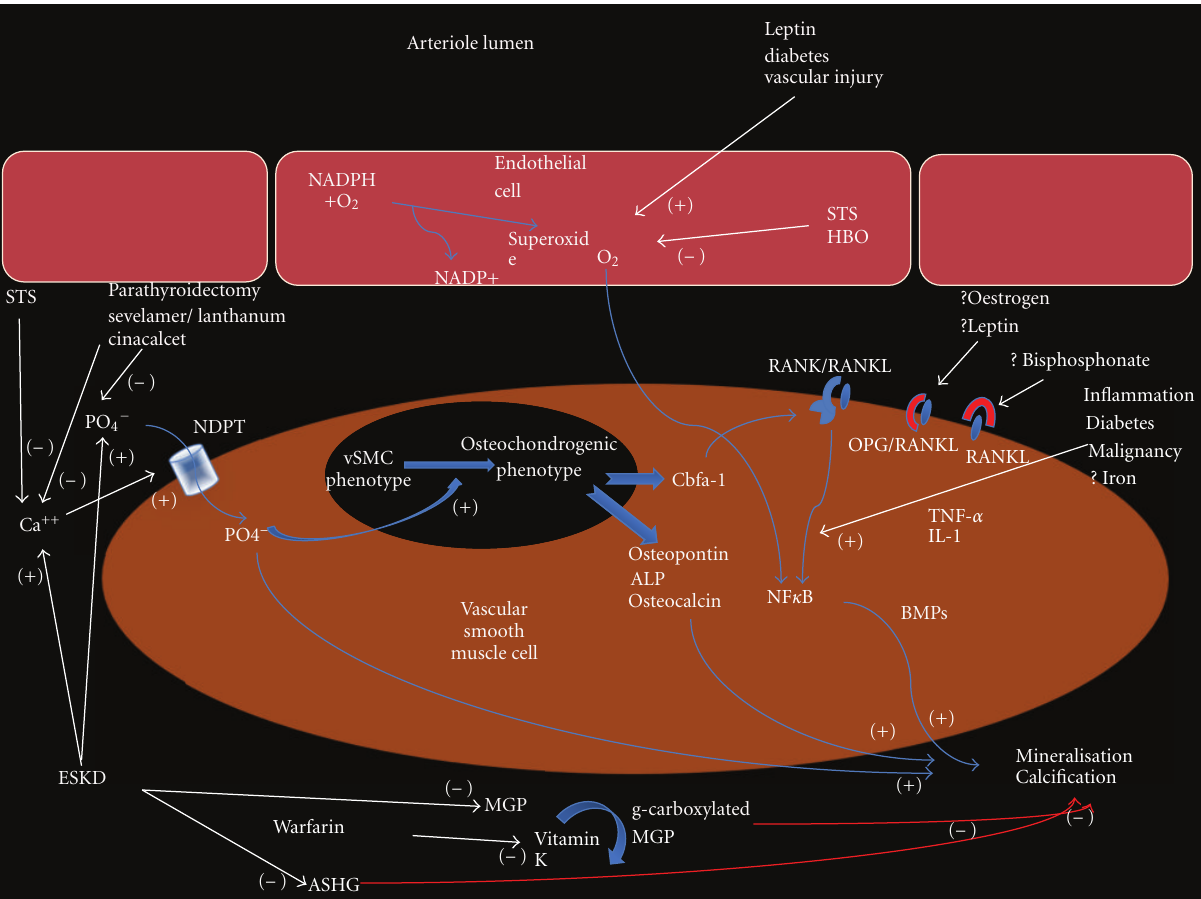
Figure 4: Schematic representation for the pathogenic mechanisms of CUA development and the potential sites of action for therapeutic intervention, where (+) indicates augmentation and ( − ) indicated inhibition; STS, sodium thiosulfate; HBO, hyperbaric oxygen; PO 4 − , phosphate; Ca ++ , calcium; NDPT, sodium-dependent phosphate cotransporter (Pit-1); vSMC, vascular smooth muscle cell; Cbfa-1, core- binding factor alpha 1; NF κ B, nuclear factor κ − B; RANK(L), receptor activator of NF κ B (ligand); OPG, osteoprotegerin; TNF- α ,tumour necrosis factor alpha; IL-1 interleukin 1; BMP, bone morphogenic protein; ESKD, end-stage kidney disease; MGP, matrix G1a protein; ASHG, α -2 Heremans-Schmid